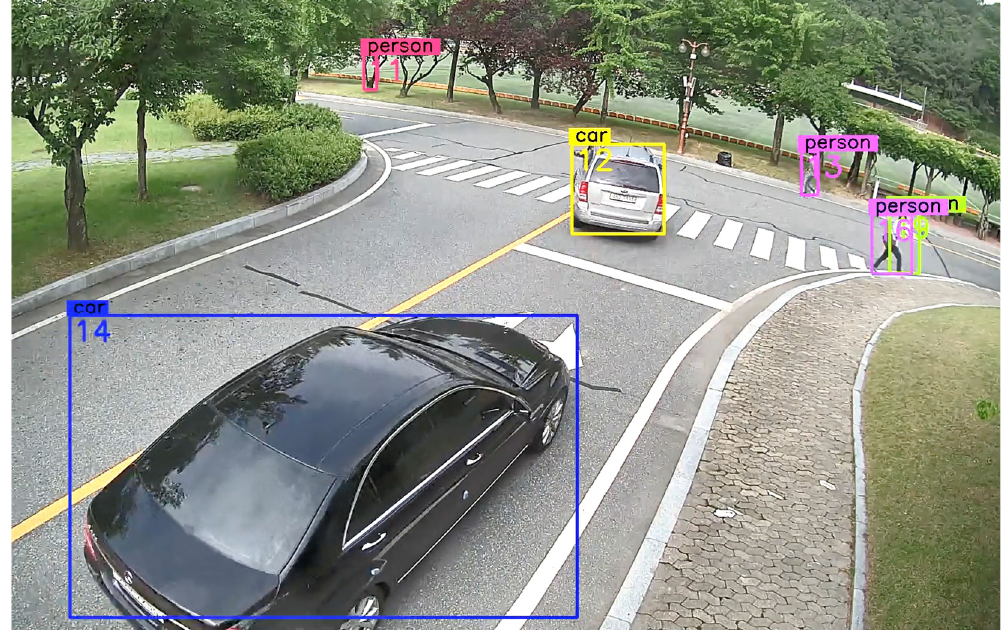
Figure 8. Objectification result for individual mobility in a testbed built to test the proposed platform.